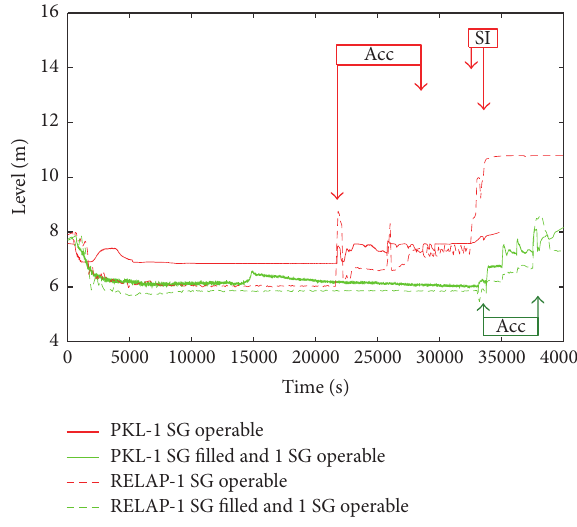
Figure 16: Vessel level. PKL versus RELAP5. Steam generators influence.